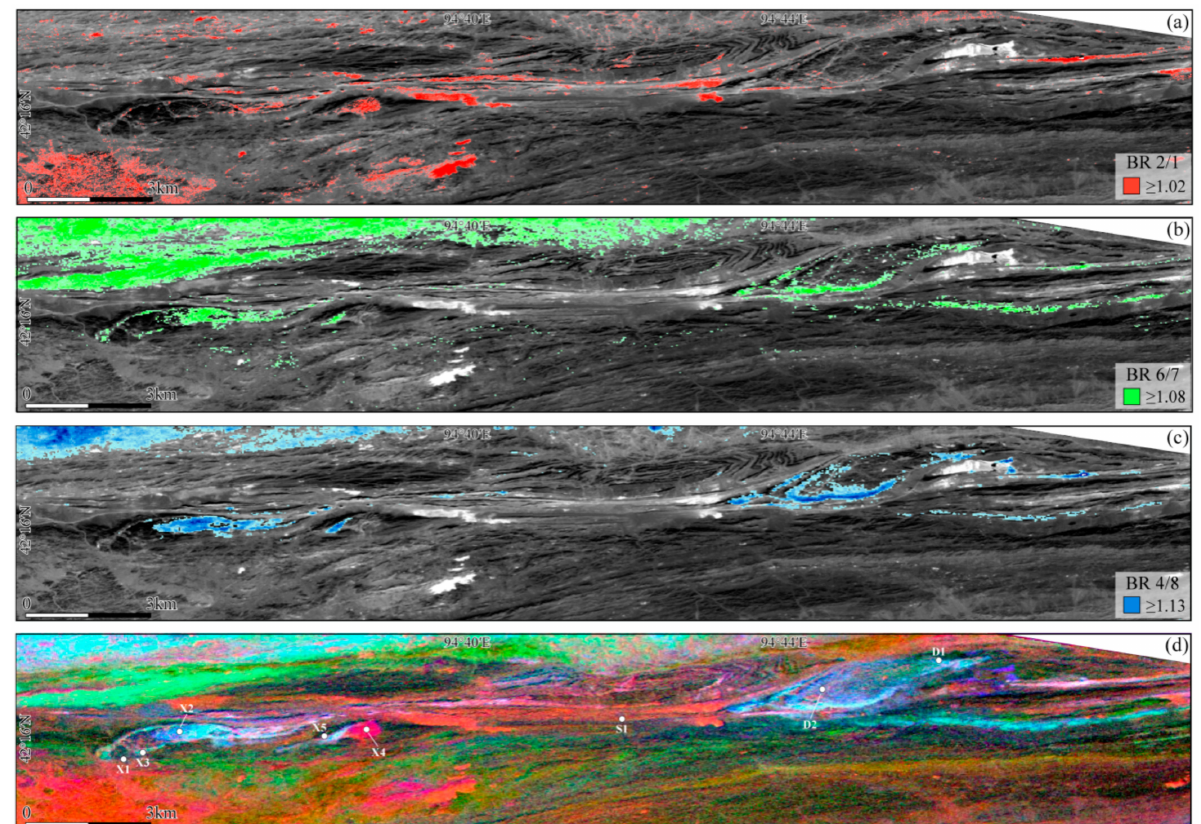
Figure 4. The lithological information extracted from the ASTER b2/b1 ( a ), b6/b7 ( b ), b4/b8 ( c ) superimposed on ASTER band 1 image and the false-color composite image of b2/b1 (R), b6/b7 (G) and b4/b8 (B) ( d ) in study area. White circles represent the location of the